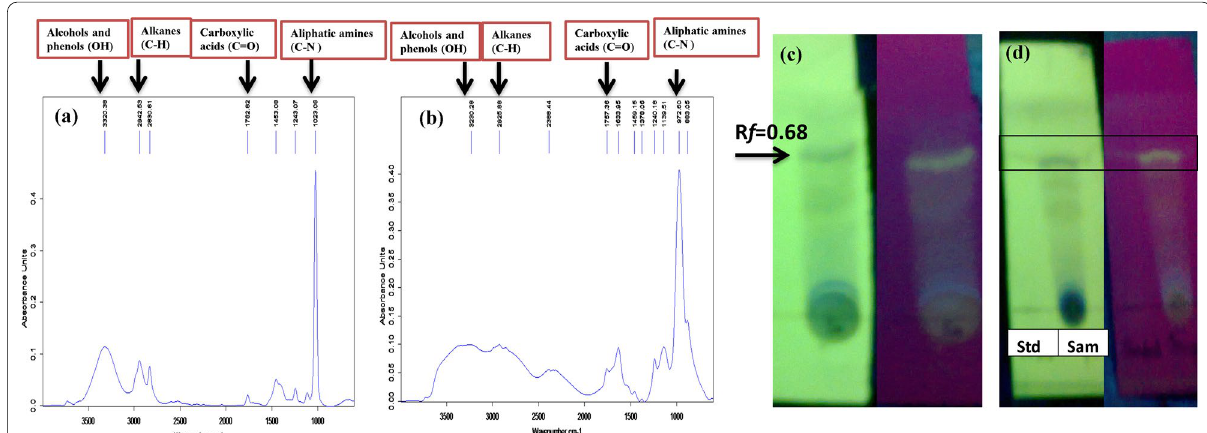
Fig. 2 FTIR spectrum and TLC profile of crude lipopeptide produced by Bacillus subtilis SNW3 in comparison to standard surfactin show as a FTIR of standard surfactin, b FTIR of crude lipopeptide extract, c TLC profile of crude lipopeptide extract, d TLC profile of crude lipopeptide in comparison to standard